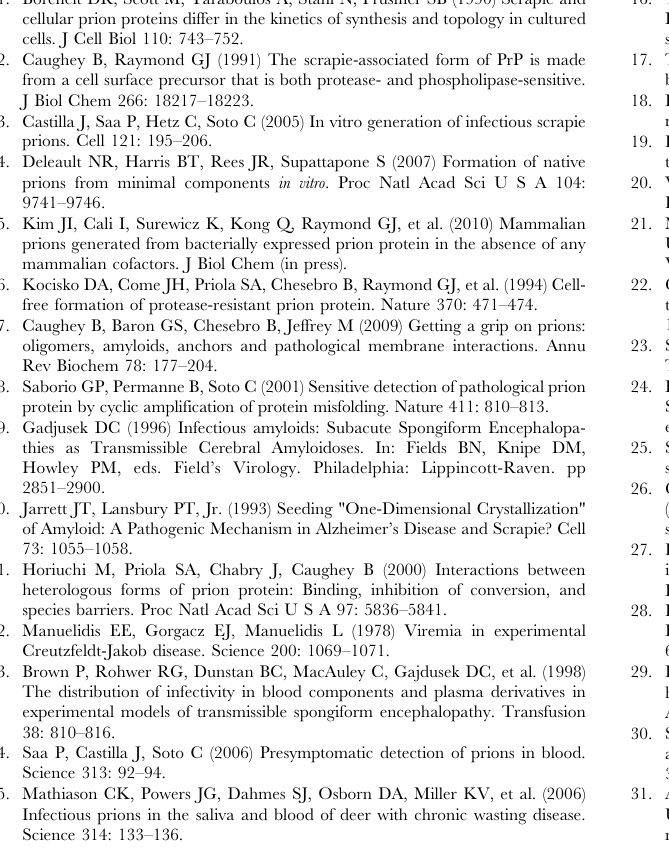
Figure 8. Sodium chloride titration for sheep, deer, and hamster RT-QuIC reactions. Dilutions of sheep scrapie (10 2 4.9 ; , 10 fg PrP Sc ) (A), deer CWD (10 2 6.3 ; , 4 fg PrP CWD ) (B), and hamster scrapie (10 2 7.3 ; , 10 fg PrP Sc ) (C) BH’s and corresponding dilutions of NBH of the same species were used to seed RT-QuIC reactions. The NaCl concentration in the reactions was varied as designated. All reactions utilized the homologous full length rPrP C substrates. The data points show the average ThT fluorescence of 4–8 replicate